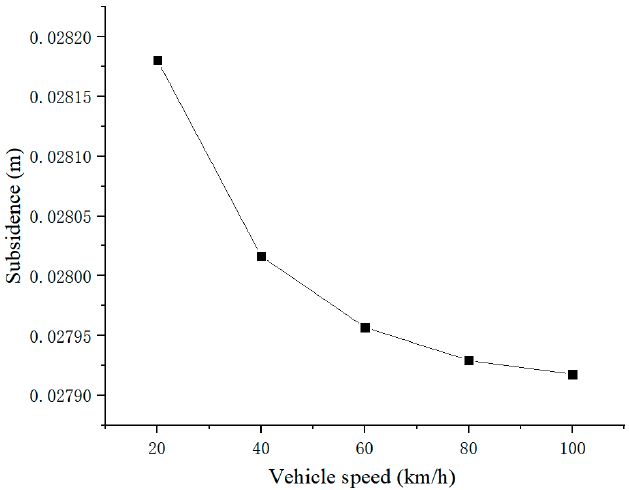
Figure 18. Variation of wall subsidence at 14.625 m under different vehicle speeds.